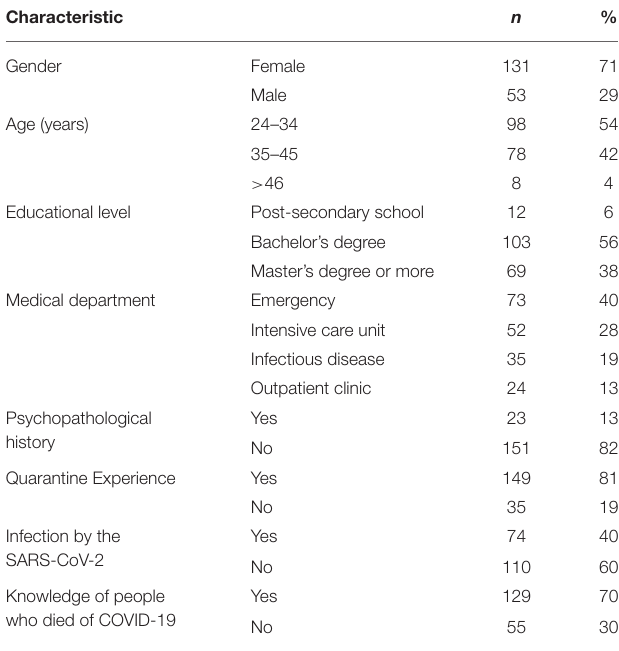
TABLE 2 | Participants’ characteristics ( n =